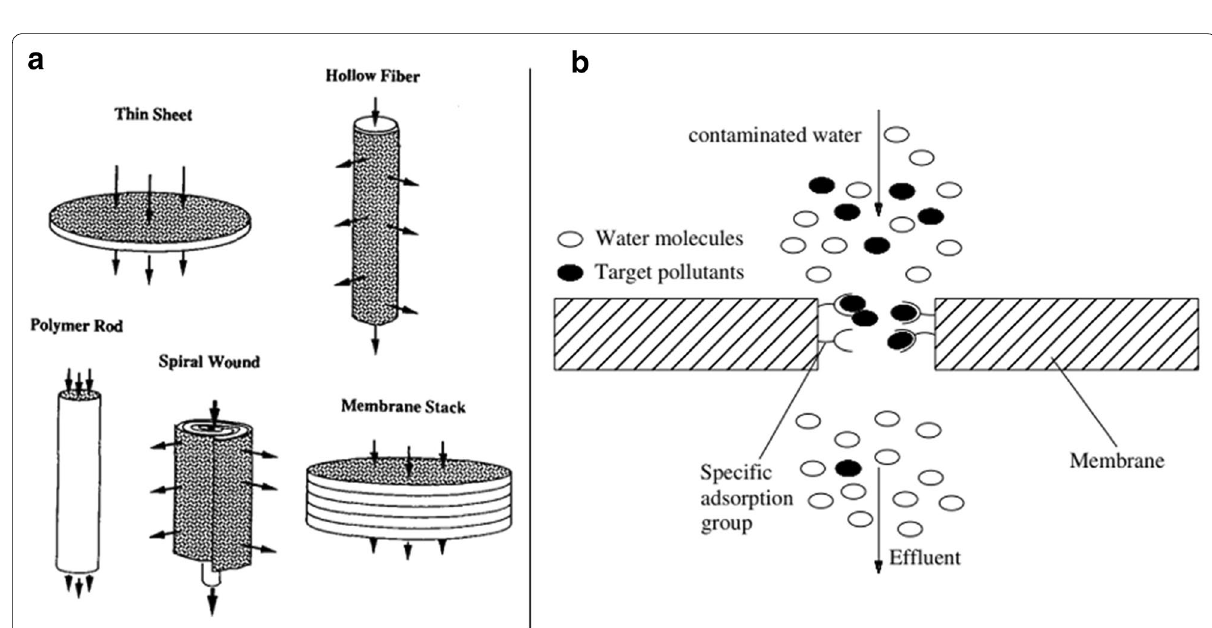
Fig. 2 a Scheme of AMs and arrows note for the directions of bulk flow (Reprinted from [13]), and b the principle of AMs (Reprinted from